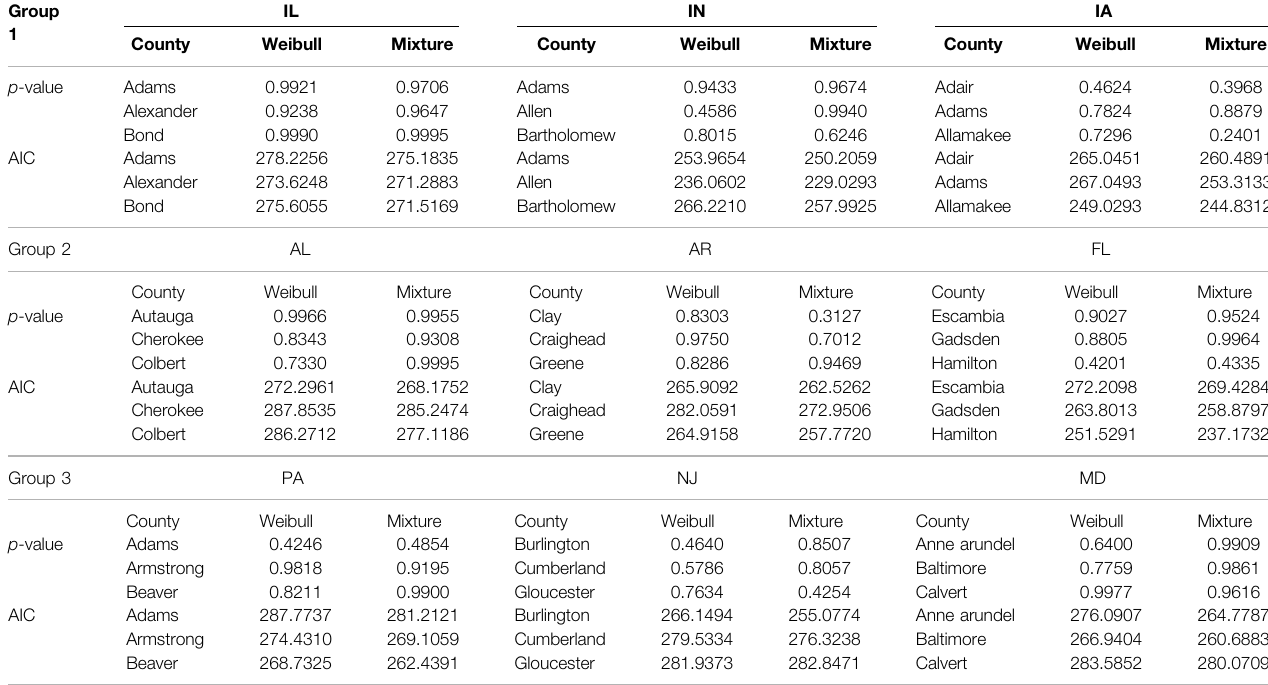
TABLE 6 | Results of Kolmogorov-Smirnov test (at 5% signi fi cance level) and the AIC value of the goodness-of- fi t test. Group 1